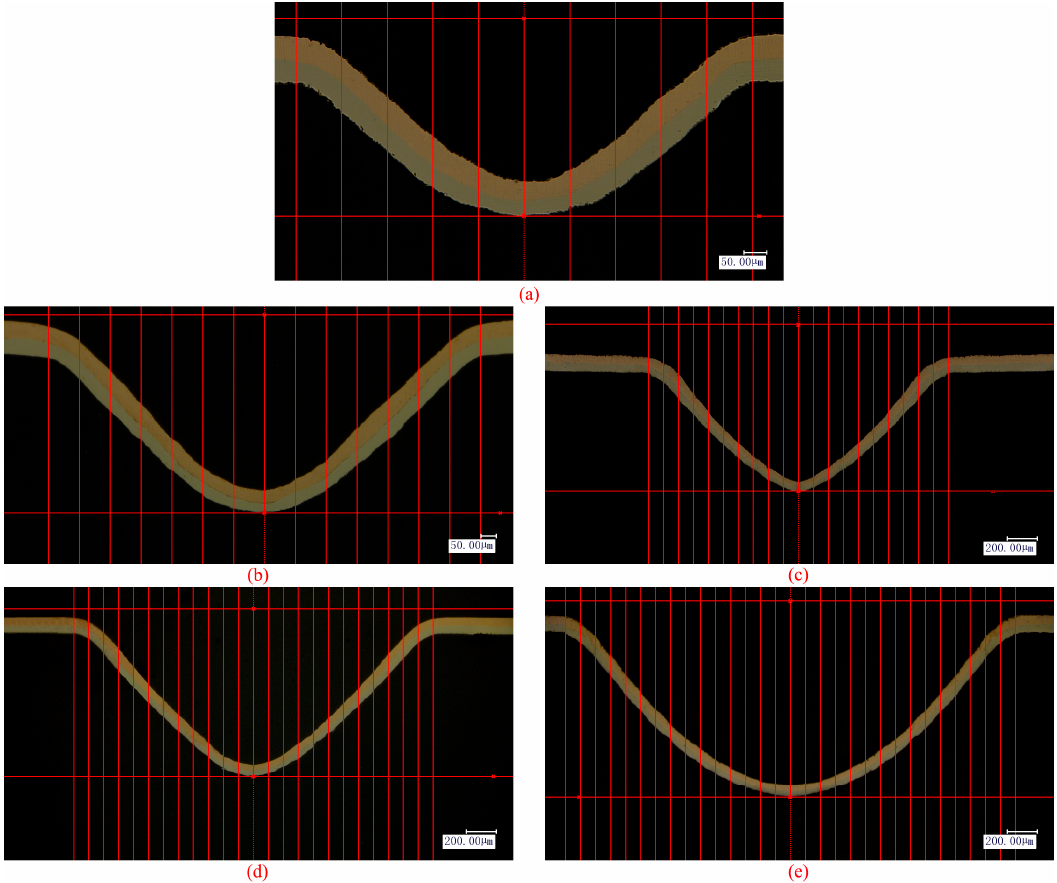
Figure 6. Measurement locations of thickness: ( a ) mold 1; ( b ) mold 2; ( c ) mold 3; ( d ) mold 4; ( e ) mold